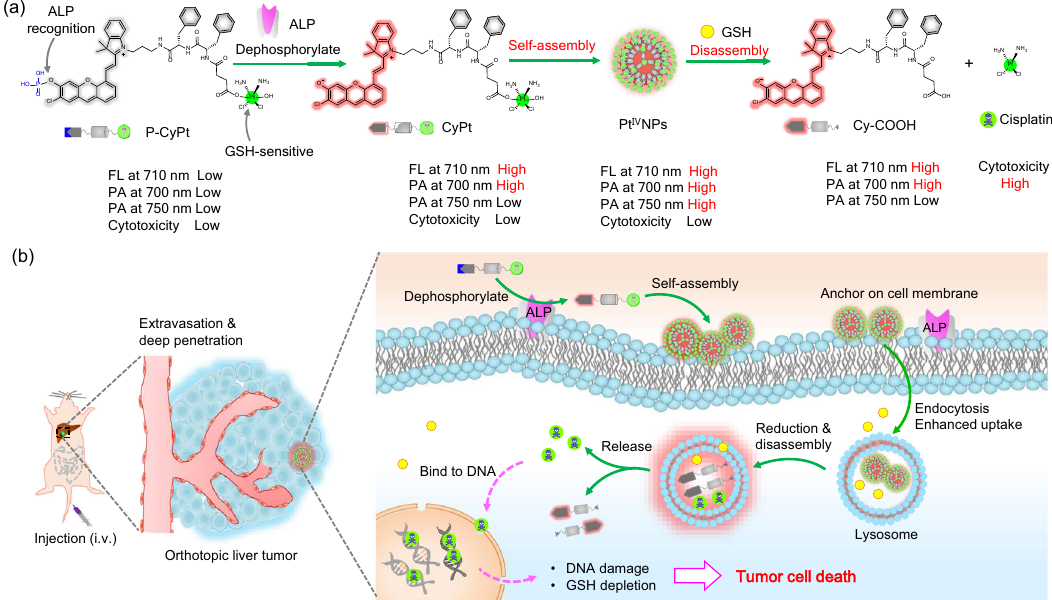
Fig. 1 | General design and proposed mechanism of P-CyPt for cancer ther- anostics. a Chemical structure of P-CyPt and proposed ALP-triggered depho- sphorylation and in situ self-assembly into Pt IV NPs, followed by GSH-triggered disassembly to release cisplatin and Cy-COOH.The NIR FL at710nm and PA signal at 700nm were both turned on; the PA signal at 750nm was turned on during the in situ self-assembly process, which was switched off during the disassembly pro- cess. b Illustration of the mechanism of P-CyPt for FL/PA bimodal imaging-guided chemotherapy of orthotopic liver tumors in vivo. Following systemic administra- tion, P-CyPt as a hydrophilic small-molecule cisplatin prodrug easily extravasates and diffuses into tumor tissues. In orthotopic liver tumors, rapid depho- sphorylation of P-CyPt into fl uorescent CyPt is initiated by membrane-bound